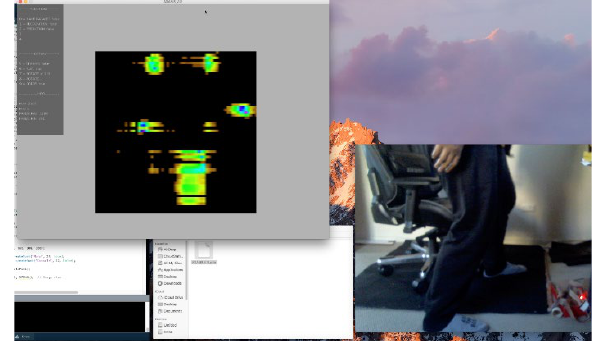
Figure 2. Example of pressure map produced by the system with associated physical interaction